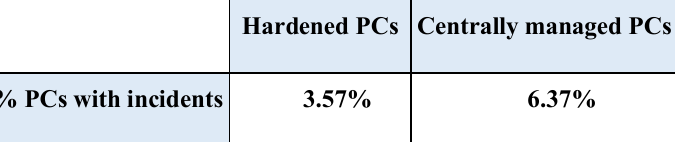
Fig 5. Hardened PC configuration